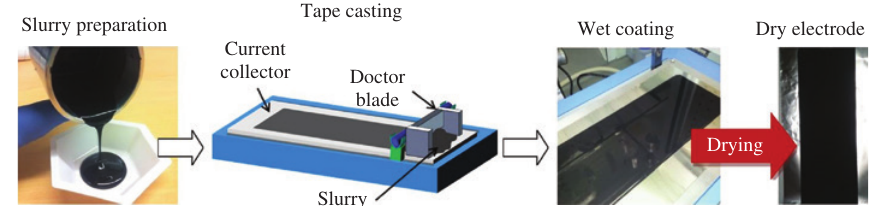
Figure 12: Processing steps for thick-film coating of composite cathode materials via tape casting.